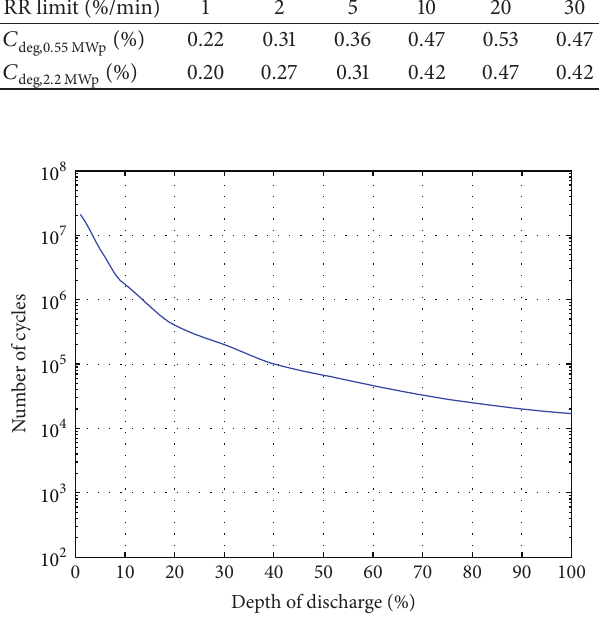
Figure 13: Maximum number of cycles as a function of DOD for an Altairnano lithium-titanate battery adapted from [17] (Altairnano ©